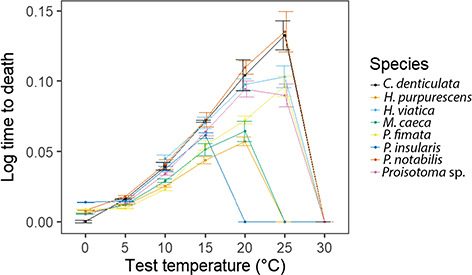
Mean egg development rate (1/days to hatching) between 0°C and 30°C for each of the species investigated here (indigenous species are M. caeca and P. insularis, the remainder are alien). Where values are zero, this typically indicates no development or very low hatching success with some development in the case of the values at 0°C. Summary data in Supplementary Table S10